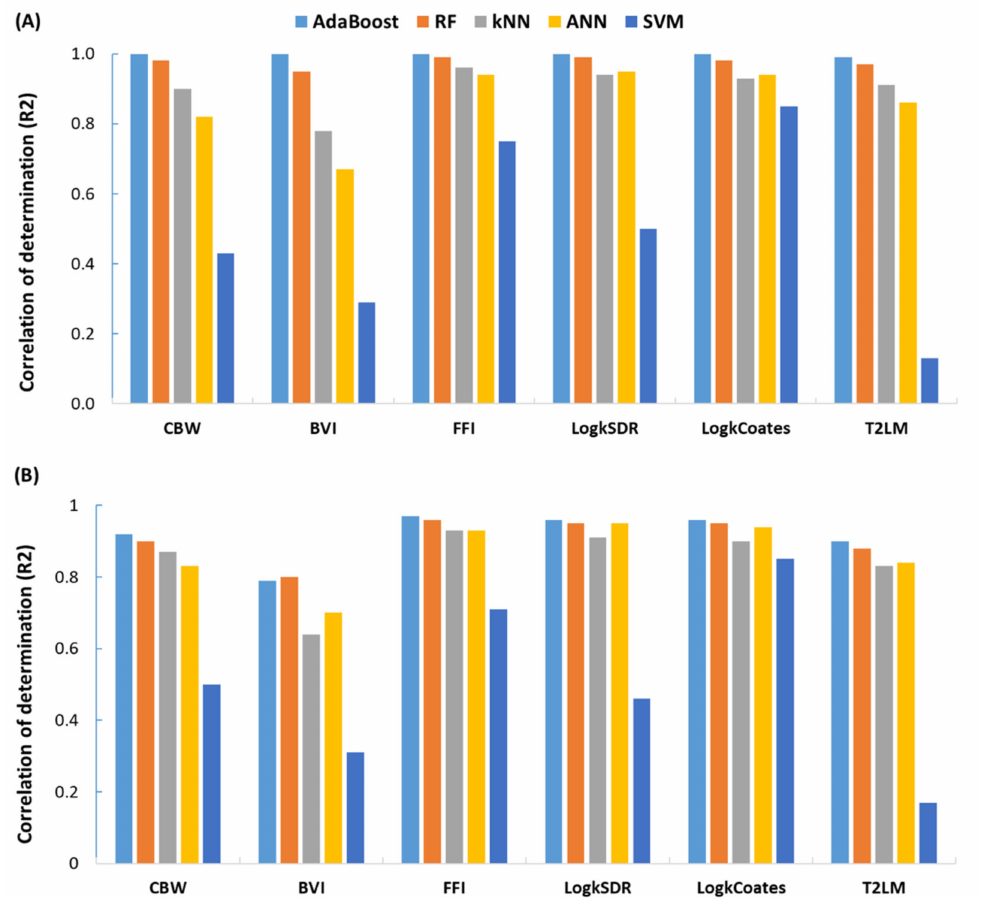
Figure 8. Performance of different ML methods for prediction of NMR log outputs for training ( A ) and blind ( B ) datasets. The AdaBoost method performs the best for both training and blind